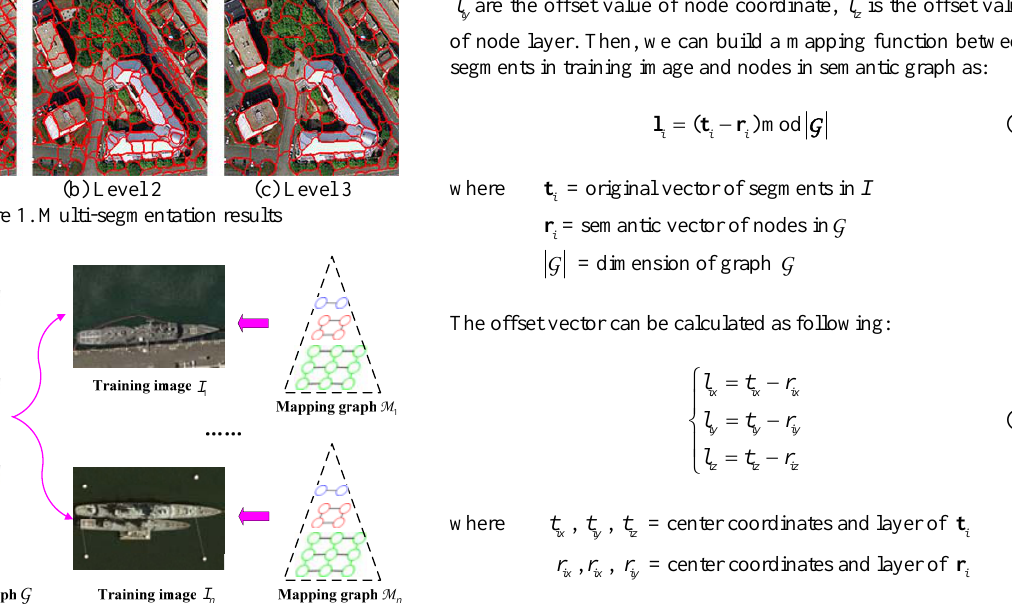
Figure 2. Hierarchical semantic graph